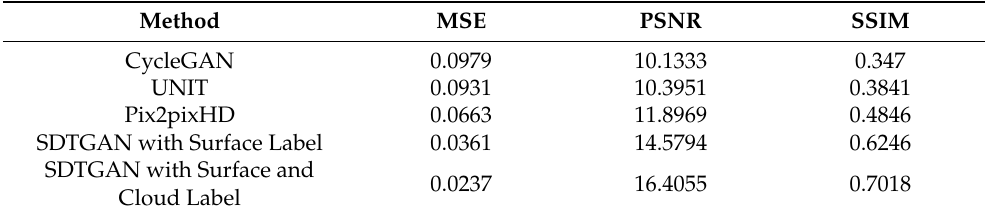
Table 4. Quality result of the translation from infrared spectrum domain to visible spectrum domain.